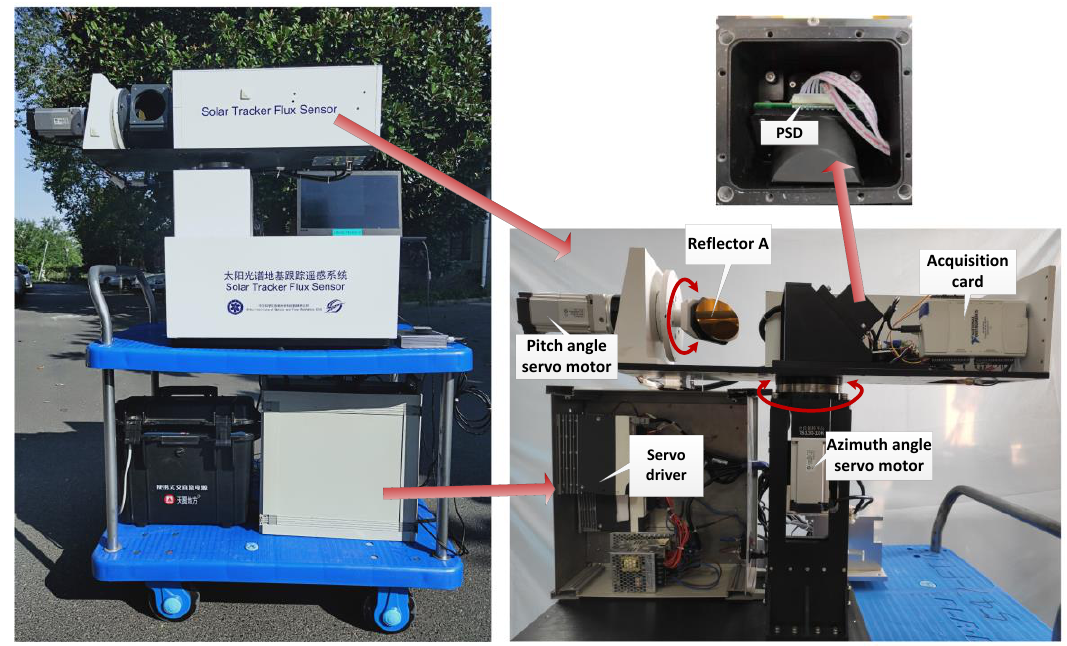
Figure 17. SOF-FTIR used for outdoor experimental tests.